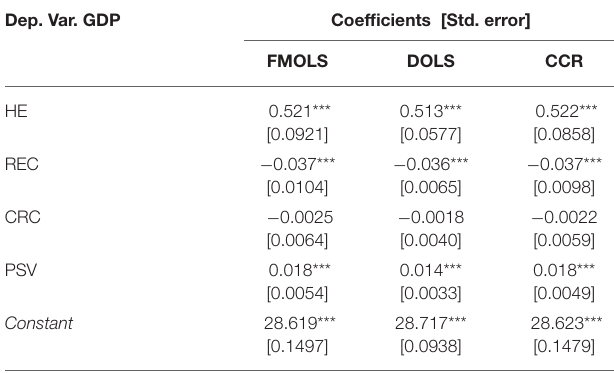
TABLE 7 | Empirical results of